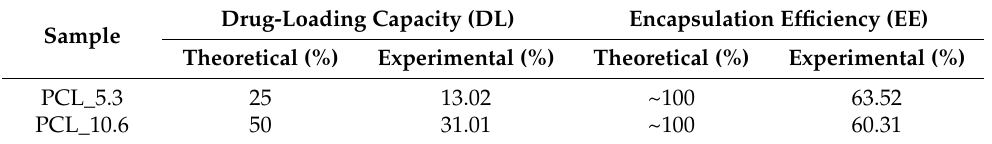
Table 4. Plantago major loading capacity and encapsulation efficiency in PCL nanofibers (n = 3).